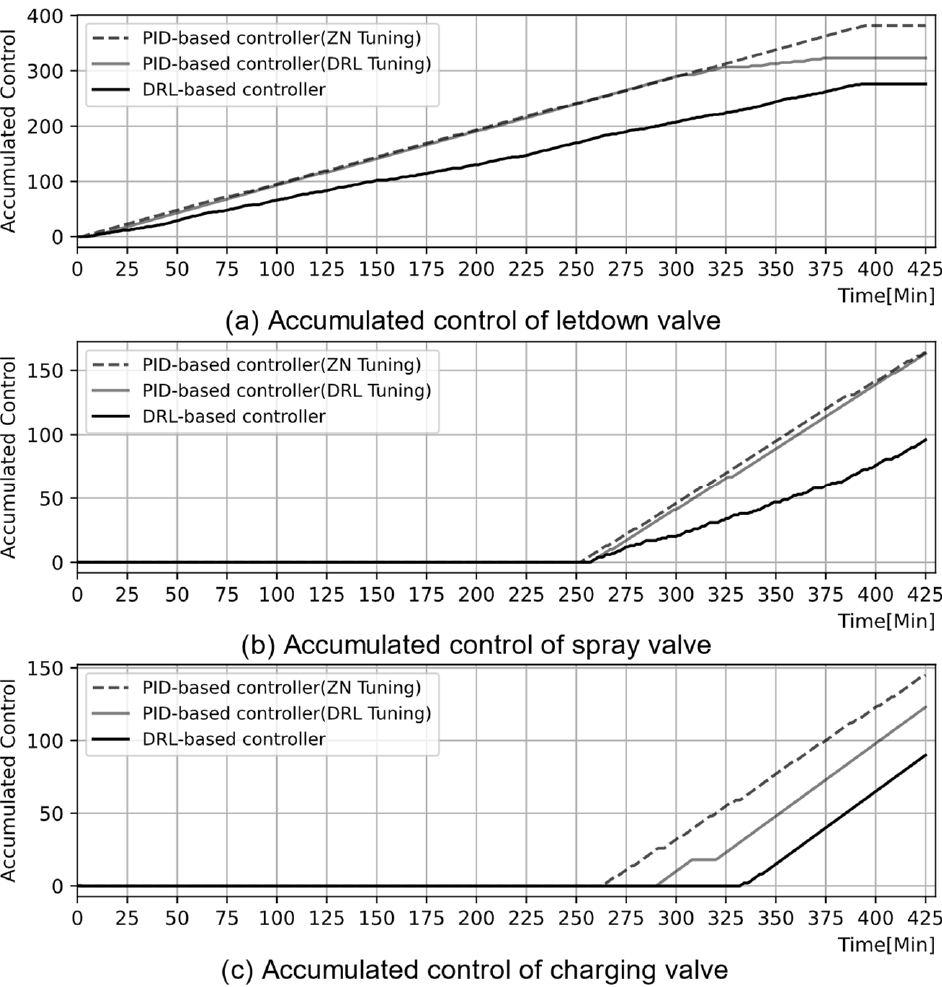
Figure 25. Total manipulation of ( a ) letdown; ( b ) spray; ( c ) charging valve during cold shutdown operation.